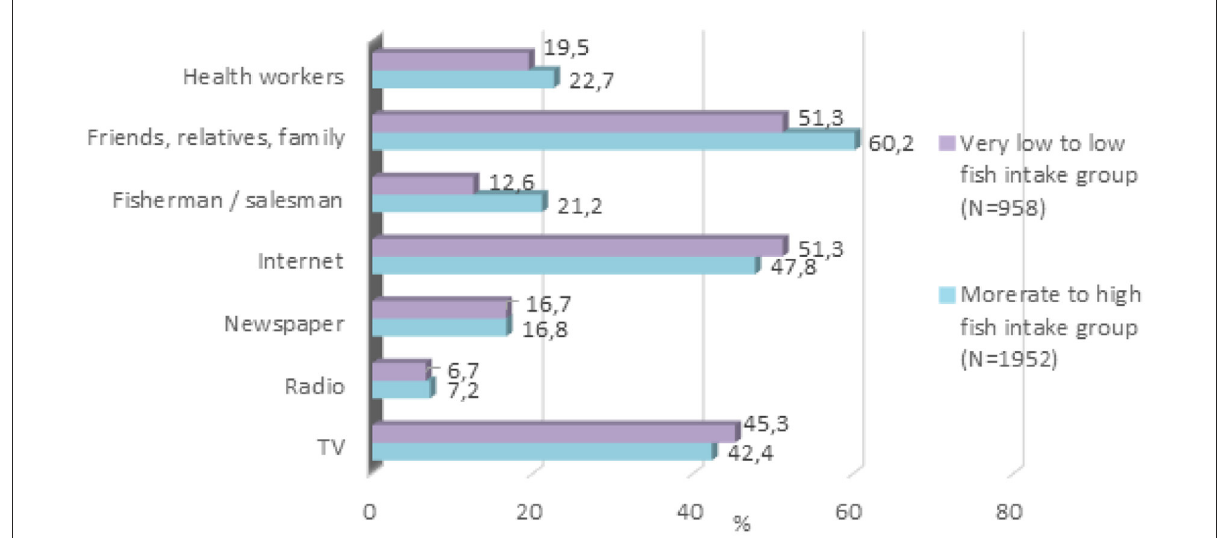
FIGURE5 All information channels for knowing the importance of consuming fishery products among groups regarding recommended fish intake.